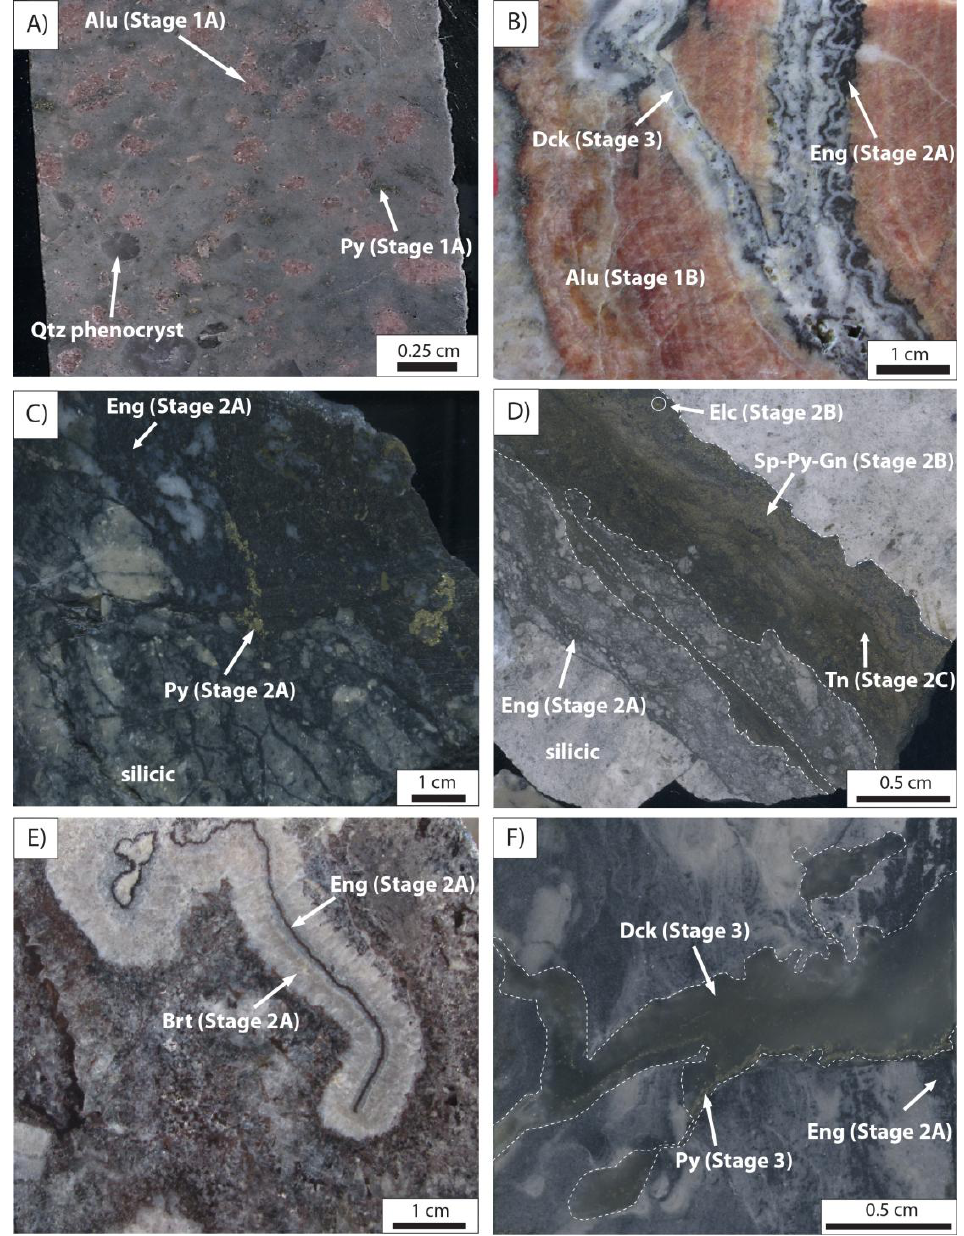
Figure 4. Photographs of relevant alteration and mineralization assemblages from Mt Carlton. ( A ) Quartz-alunite-pyrite alteration (Stage 1A) developed in a quartz-feldspar phyric rhyodacite. Magmatic-hydrothermal alunite occurs as disseminations and as replacements of pre-existing feldspars. ( B ) Plumose alunite vein of magmatic-steam origin (Stage 1B). After deposition of alunite, the vein was re-opened along the central line to form an enargite vein (Stage 2A). The composite vein was then overprinted by dickite (Stage 3). ( C ) Silicic hydrothermal breccia cemented by Stage 2A enargite-pyrite ore. ( D ) Silicic altered rhyodacite crosscut by a fine enargite-cemented hydrothermal breccia (Stage 2A). The enargite breccia is crosscut by a sphalerite-pyrite-galena vein containing specules of electrum (Stage 2B). The sphalerite vein is in turn locally overprinted by tennantite (Stage 2C). ( E ) Stage 2A enargite veinlet with a halo of barite. ( F ) Disseminated Stage 2A enargite mineralization crosscut by a Stage 3 dickite-pyrite vein. Mineral abbreviations: Alu—alunite; Brt—barite; Dck—dickite;